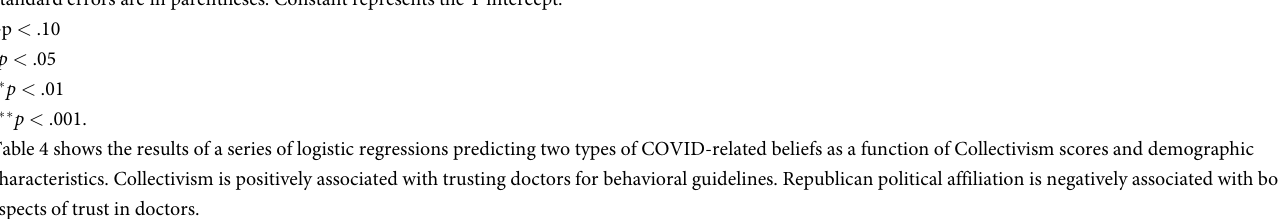
Table 4 shows the results of a series of logistic regressions predicting two types of COVID-related beliefs as a function of Collectivism scores and demographic characteristics. Collectivism is positively associated with trusting doctors for behavioral guidelines. Republican political affiliation is negatively associated with both aspects of trust in